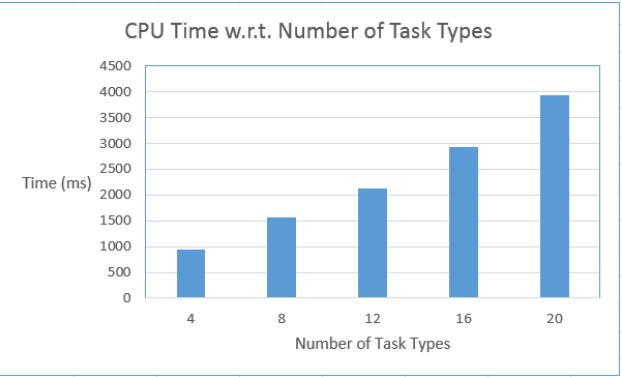
Figure 9. CPU time with respect to number of task types (Problems 21~25).